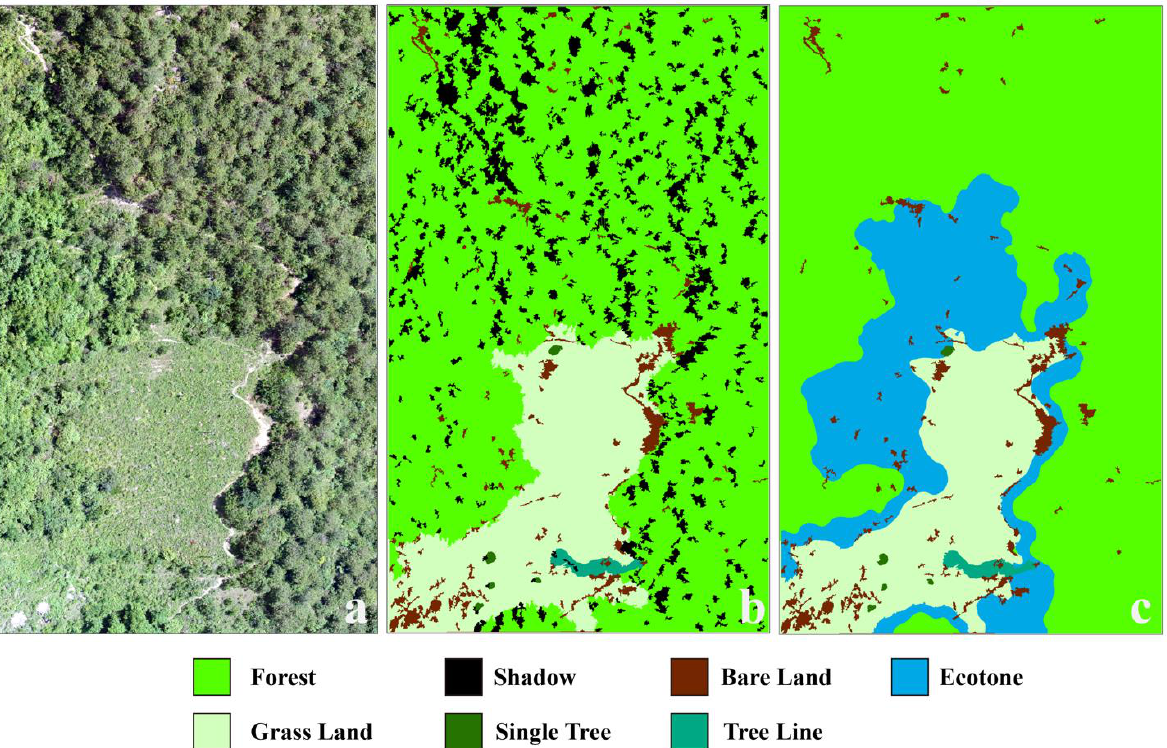
Figure 5. An orthoimage of the study area ( a ), a landscape patter map derived from OBIC ( b ), and ( c ) a landscape including the ecotones extracted (shadows removed). Table 2. A series of common landscape metrics used to quantify some elements of the landscape. Landscape Metrics Forest Bare Land